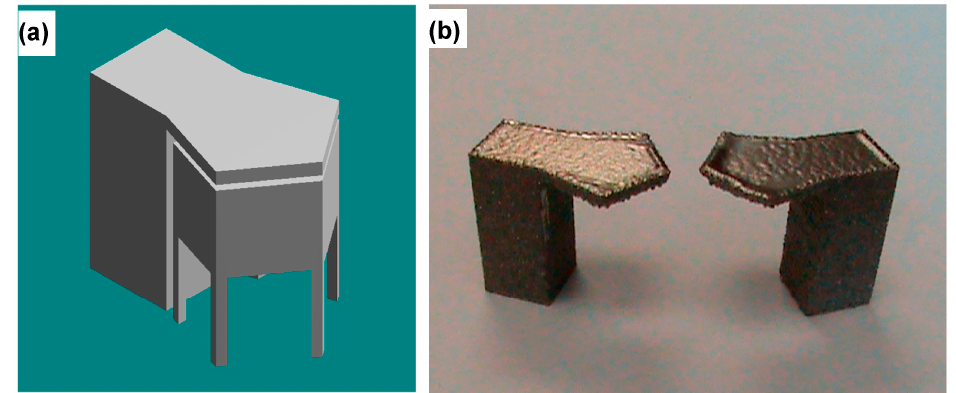
Figure 11. ( a ) Example of CAD model of a curved overhang. ( b ) Fabricated overhang parts, using heat supports, with different geometries, from Left to Right: Convex curve, concave curve, 30° slope upward and downward.